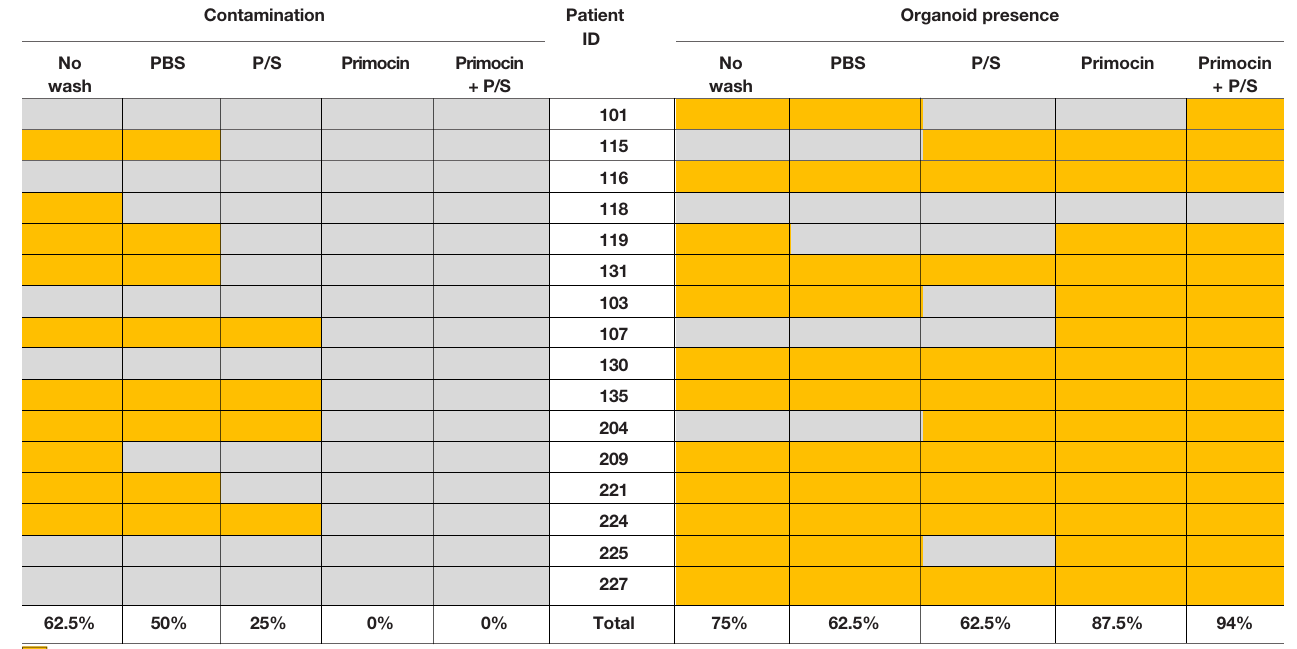
TABLE 2 | Summary of contamination events detected for each PDO culture for each washing